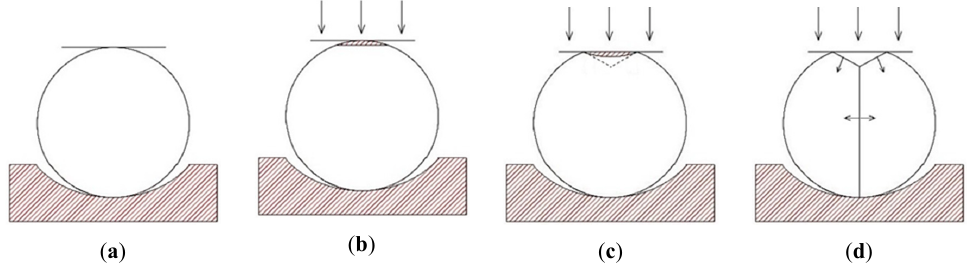
Figure 17. Breaking process under ball–plane contact condition: ( a ) original state; ( b ) local breakage; ( c ) formation of cone core; ( d ) particle breakage.